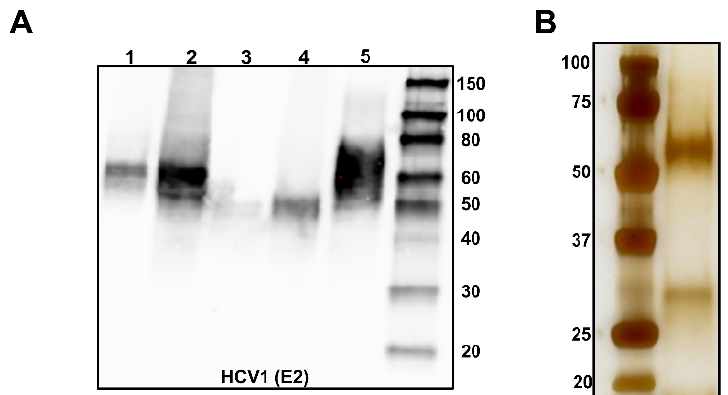
Figure 3. Optimization of expression and purification. ( A ) Relative expression of mbE1E2 in HEK 293F cells (Lanes 1 and 3) versus Expi293F cells (Lanes 2 and 4) analyzed by Western blotting probed with the anti-E2 antibody HCV1. A standard of 250 ng of sE2 is included as a reference (Lane 5). The relative expression levels of the constructs based on quantification of band intensity are 0.26 for Lane 1, 0.81 for Lane 2, 0.09 for Lane 3, 0.31 for Lane 4, and 1.0 for the standard in Lane 5. ( B ) mbE1E2 purified as described in [25] and analyzed by silver-stained SDS-PAGE.